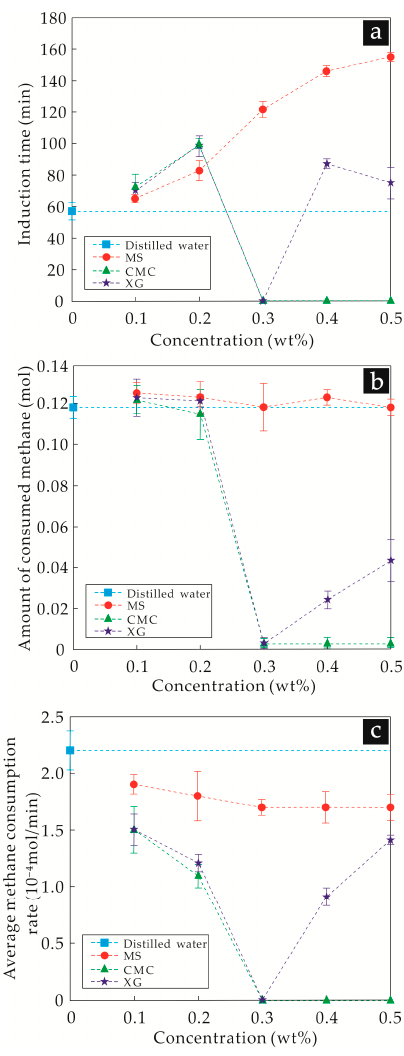
Figure 2. Hydrate formation ( a ) induction time, ( b ) amount, and ( c ) rate as a function of the concentrations of thickeners in solution when the driving force is weak. MS: modified starch, CMC: carboxymethylcellulose sodium, XG: xanthan gum.